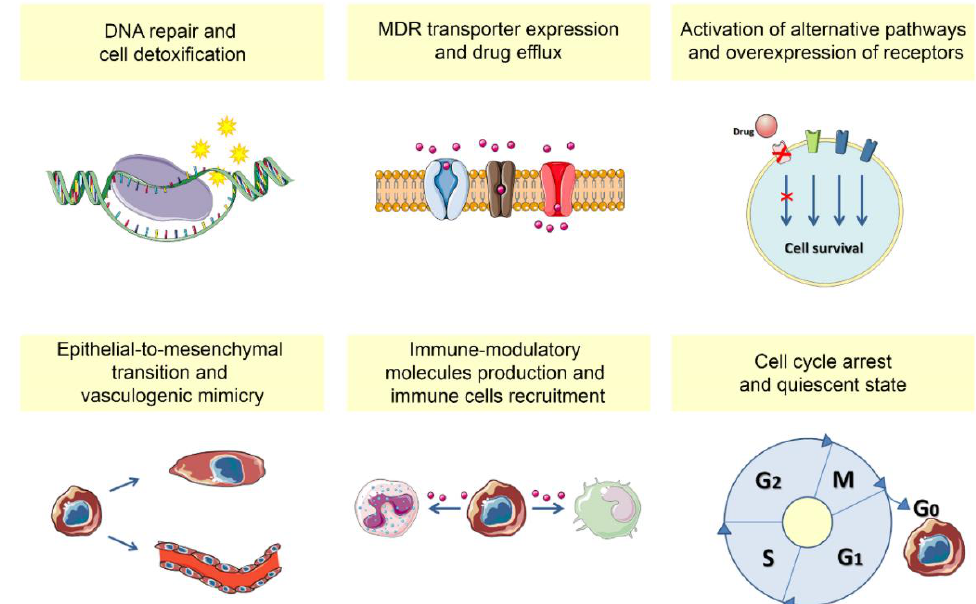
Figure 1. Molecular mechanisms helping CSCs in treatment-escaping strategies. DNA repair, cell detoxification, drug efflux, cell cycle arrest are mainly related to chemo-radiotherapy resistance. The escape from targeted, antiproliferative, therapies is mediated by the activation of alternative signaling pathways, whereas the escape from targeted, antiangiogenic therapies is mediated by vasculogenic mimicry. The ability to shape the immune contexture is related to resistance to immunotherapies. Table 1. Novel therapeutic approaches targeting CSCs. Specific molecules have been recently approved for the treatment of breast cancer (CDK4/6 inhibitors), basal cell carcinoma (Hedgehog inhibitors), chronic lymphocytic leukemia and acute myeloid leukemia (Bcl2 inhibitors). Other CSC-targeted therapies are currently under clinical/preclinical investigation.